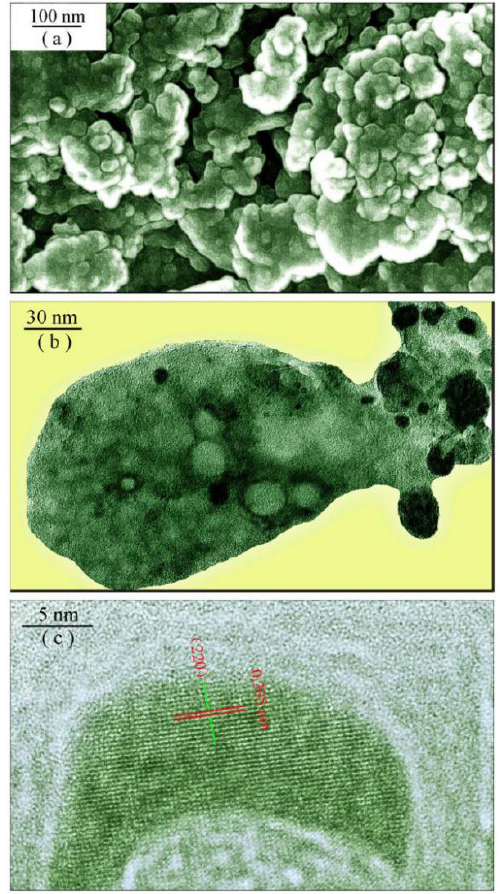
Figure 2. ( a ) SEM micrograph of undoped SrAl 2 O 4 showing the agglomerates; ( b ) TEM micrograph of undoped SrAl 2 O 4 showing nanocrystals in an agglomerate; ( c ) High-resolution TEM micrograph of undoped SrAl 2 O 4 showing the lattice of SrAl 2 O 4 nanocrystals in an agglomerate.